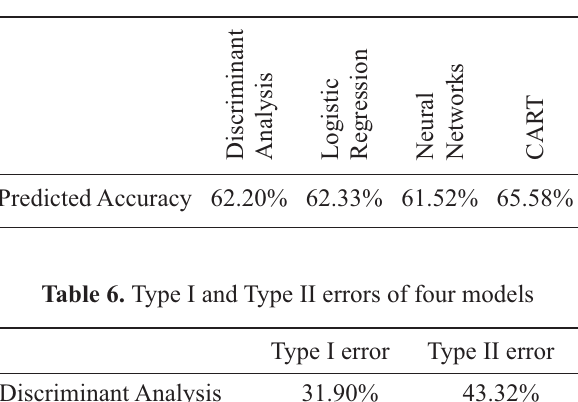
Table 5. Comparison of credit scoring models (Discriminant Analysis, Logistic regression, Neural Networks, CART)